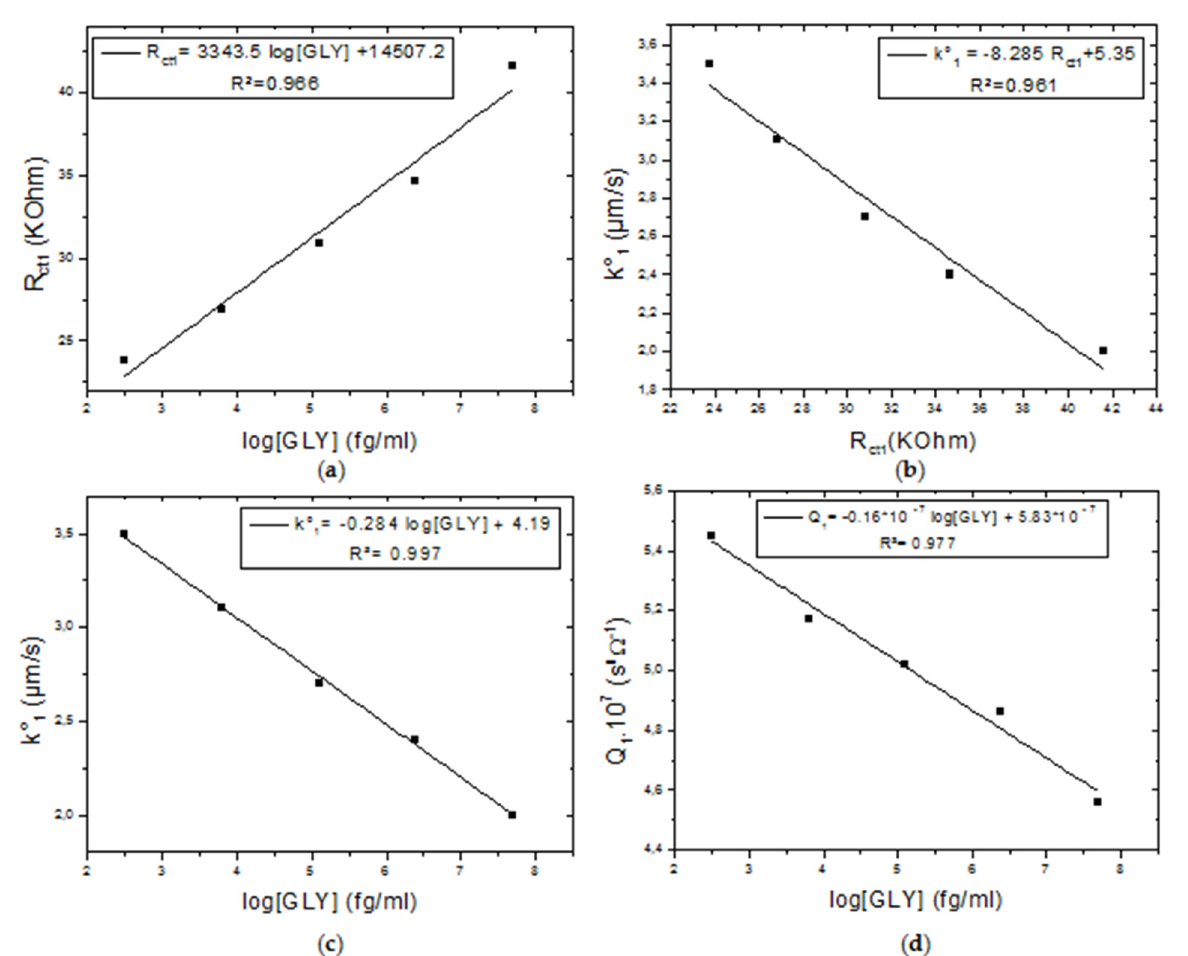
Figure 3. Calibration curves of CS-MIPs/CMA/Au. ( a ) k 1 ◦ = f(log[GLY]), ( b ) k 1 ◦ = f(Rct1) for different [GLY], ( c ) R ct1 = f(log[GLY]), ( d ) Q 1 = f(log[GLY]). ([GLY] = 0.31 pg/mL–6.25 pg/mL–125 pg/mL–2.5 ng/mL–50 ng/mL).